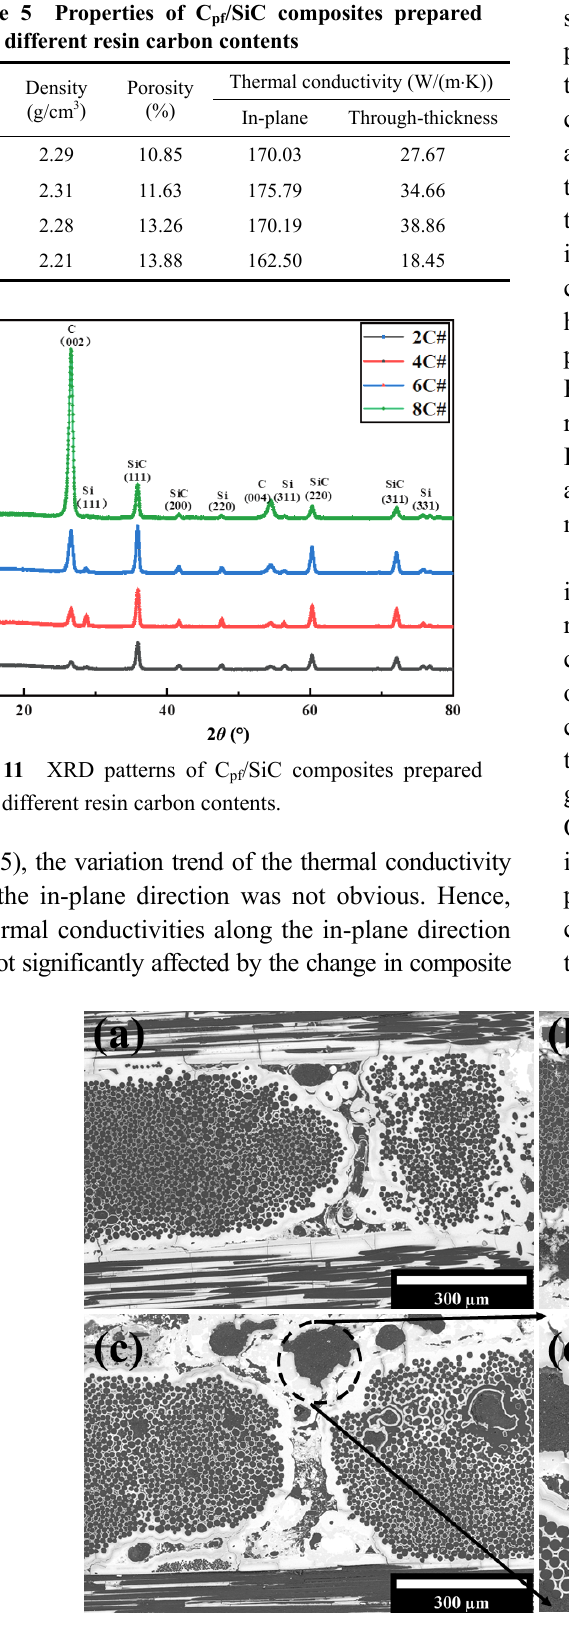
Fig. 12 BSE images of C pf /SiC composites prepared with different resin carbon contents: (a) 4C#, (b) 6C#, and (c)